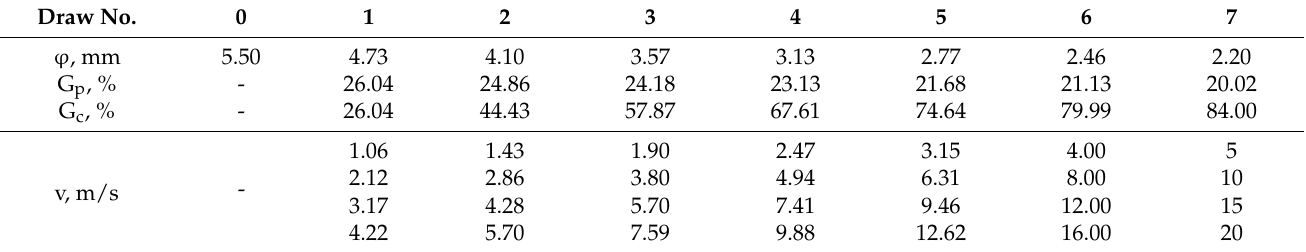
Table 1. Distribution of single reductions, G p , the total reduction, G c and drawing speed